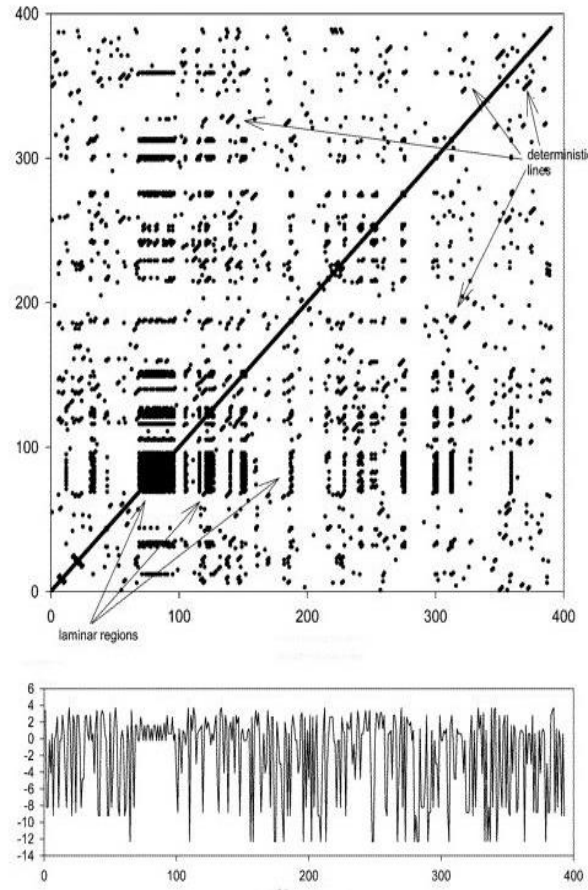
Figure 1. The black dots correspond to recurrences of pairs of points having their time coordinates reported on the x and y axes of the graph. Adjacent-in-time recurrences define deterministic lines (parallel to the main diagonal), while laminar regions are horizontal (vertical) lines of recurrences in the plot. Both deterministic and laminar lines are indicated by arrows in the figure. In this case, embedding dimension p = 4, and the radius was set to 1/10 of mean distance (modified from [21]).